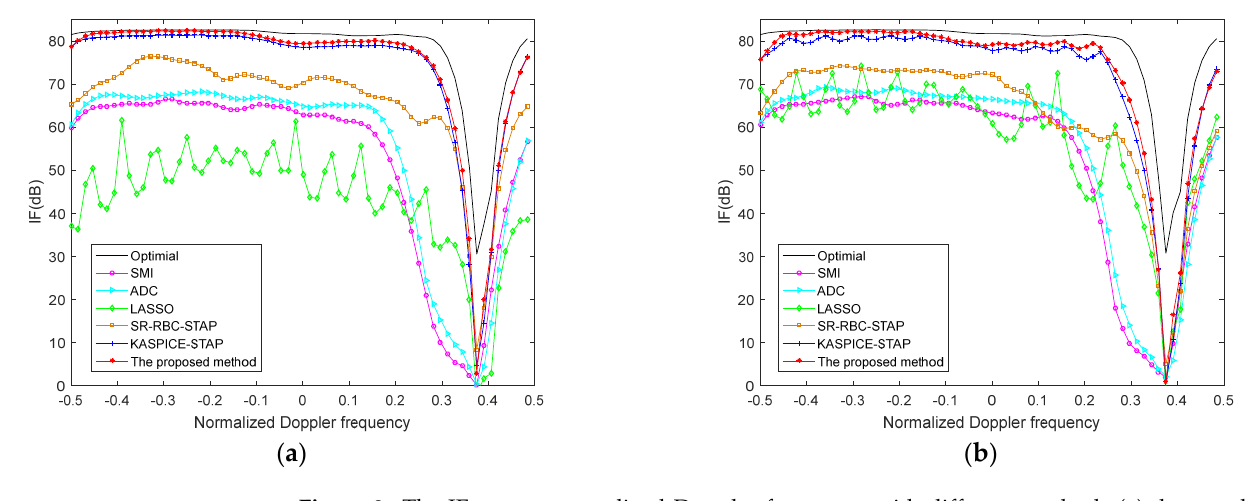
Figure 8. The IF versus normalized Doppler frequency with different methods ( a ) the standard variance of clutter spectrum spread is 0.22 m/s; ( b ) the standard variance of clutter spectrum spread is 0.56 m/s.